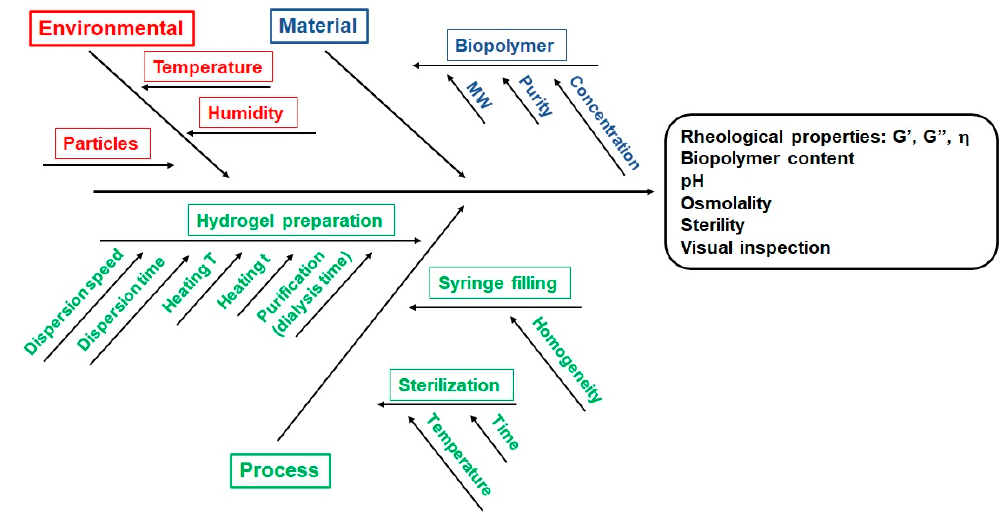
Figure 6. Ishikawa diagram for the fabrication of the injectable